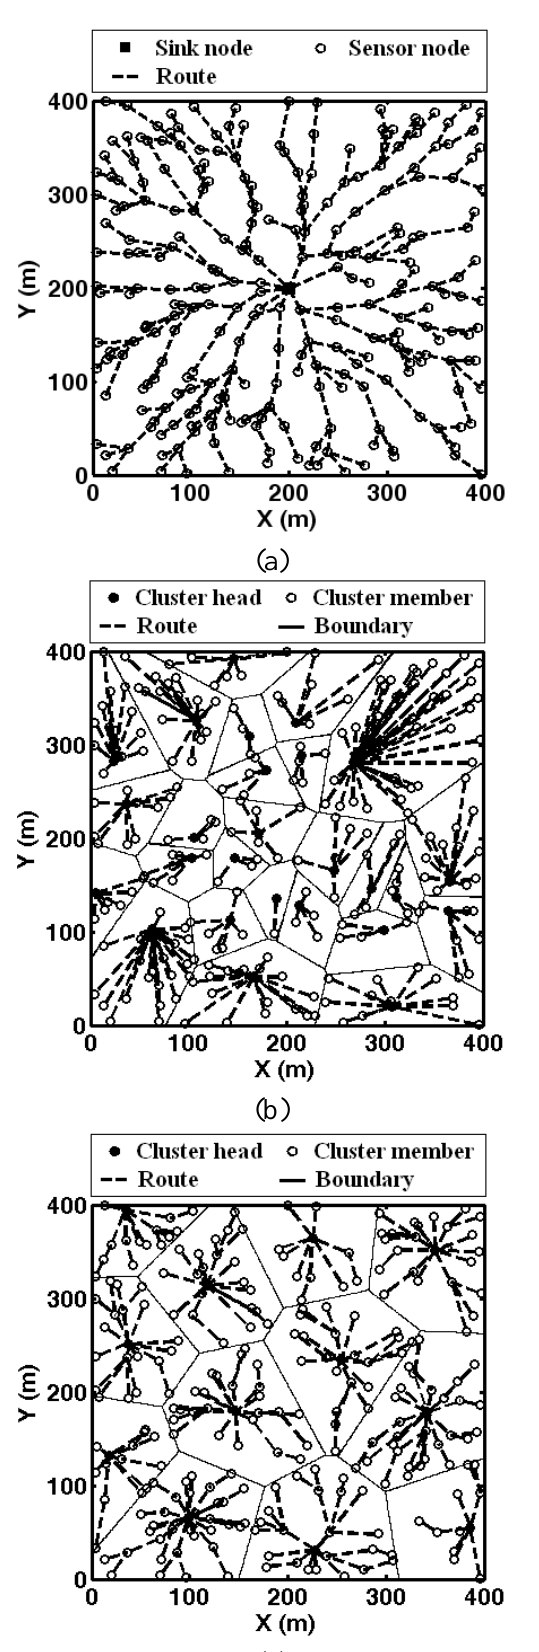
Figure 8. Routing scheme with different approaches: (a) lowest cost path; (b) LEACH; (c)